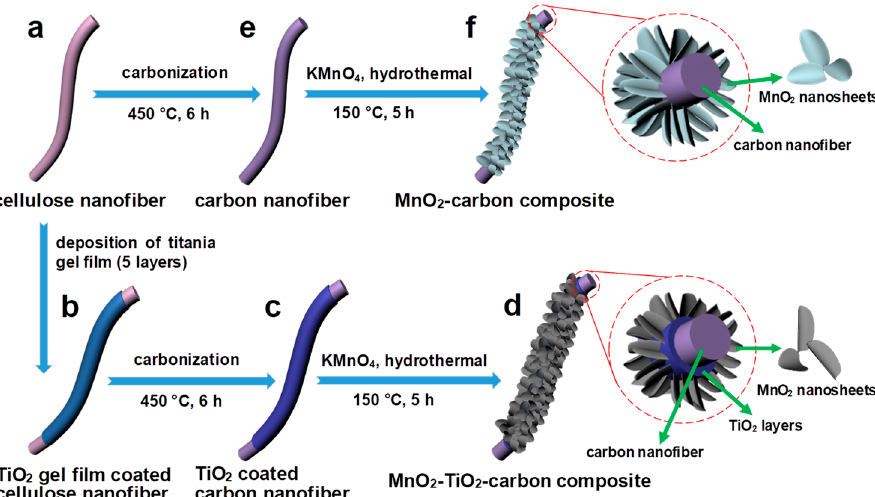
Scheme 1. Schematic illustration of the fabrication processes of the MnO 2 -TiO 2 -carbon ( a – d ) and MnO 2 -carbon ( a – f ) composites derived from natural cellulosic substances. ( b ) The TiO 2 gel film coated cellulose nanofiber was obtained by means of a surface sol–gel process. ( c ) The TiO 2 coated carbon nanofiber and ( e ) the carbon nanofiber were fabricated through carbonization of the TiO 2 gel film coated cellulose nanofiber and the cellulose nanofiber in an argon atmosphere, respectively. ( d ) MnO 2 -TiO 2 -carbon and ( f ) MnO 2 -carbon were fabricated via a hydrothermal process by em-